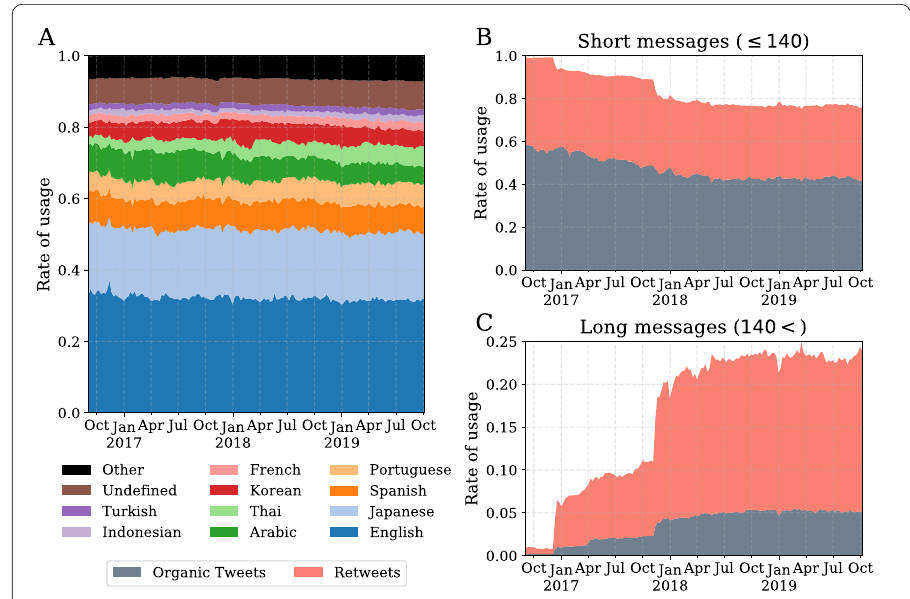
Figure 13 Weekly rate of usage for short and long messages. ( A ) Rate of usage for the top-10 used languages averaged at the week scale for the past three years. The introduction of long messages (i.e., above 140 but below 280 characters) does not change the overall language usage on the platform. ( B )–( C ) The growth of long messages over time across organic and retweeted messages. We observe a much higher ratio